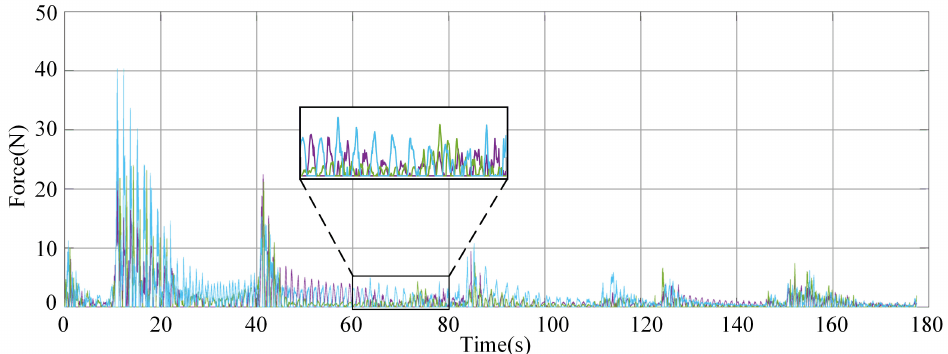
Figure 17. Tension curve of three driving cables in the 3rd